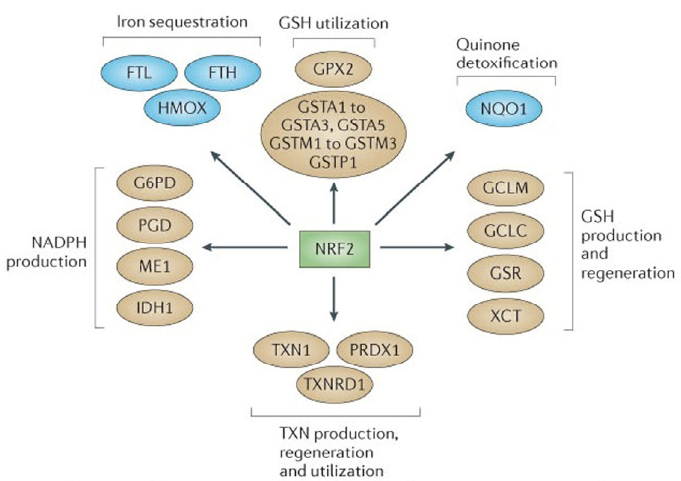
Figure 3. NRF2 as the master regulator of antioxidant responses . Nuclear factor